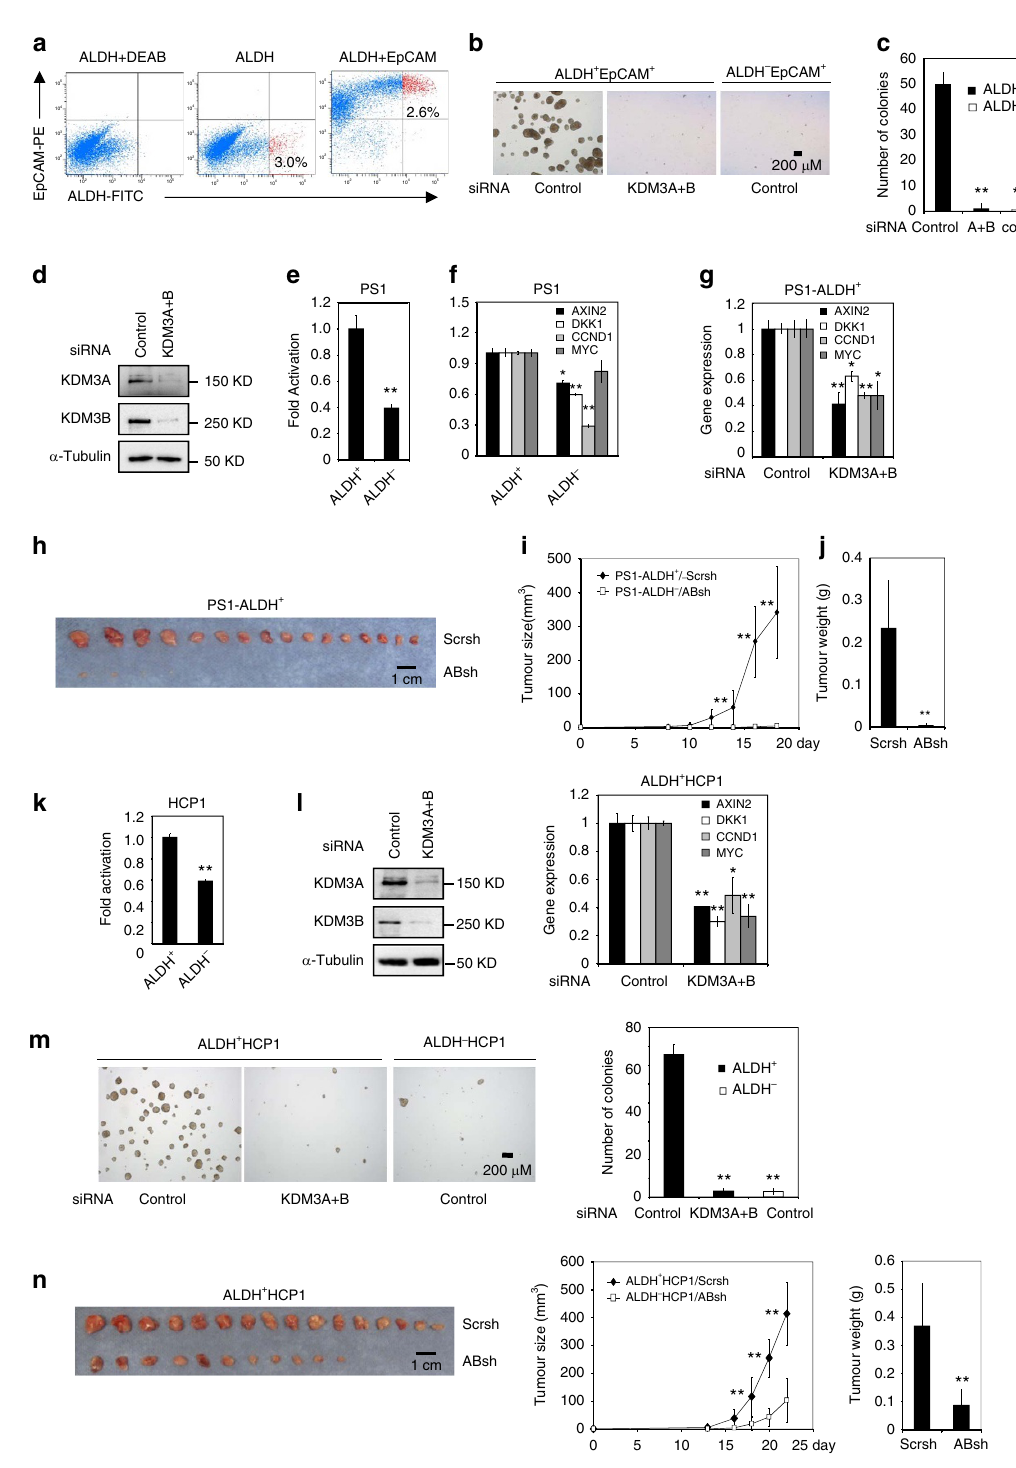
Figure 4 | KDM3A/B are required to maintain tumorigenic potentials of human colorectal CSCs. ( a ) Isolation of ALDH þ EpCAM þ cells from human CRC tissues of patient case #1 (PS1) by FACS. ( b , c ) The knockdown of KDM3A/B inhibited tumorsphere formation of ALDH þ EpCAM þ cells from PS1. ** P o 0.01, unpaired two-tailed student’s t -test ( n ¼ 3). ( d ) The knockdown of KDM3A/B by siRNA in ALDH þ EpCAM þ cells from PS1. ( e ) The Topflash activity was significantly higher in ALDH þ EpCAM þ cells than in ALDH (cid:2) EpCAM þ cells from PS1. ( f ) The expression of Wnt target genes was higher in ALDH þ EpCAM þ cells than in ALDH (cid:2) EpCAM þ . ( g ) The knockdown of KDM3A/B inhibited the expression of AXIN2, DKK1, CCND1 and MYC in ALDH þ EpCAM þ cells from PS1 ( h – j ) The knockdown of KDM3A/B significantly inhibited tumour growth of ALDH þ EpCAM þ cells in Nude mice. Tumour growth ( i ) was monitored for 3 weeks and the weight of the tumors from each group ( j ) were compared at the end of experiments. ** P o 0.01, unpaired two-tailed student’s t -test ( n ¼ 16). ( k ) The Topflash activity was significantly higher in ALDH þ HCP1 cells than in ALDH (cid:2) HCP1 cells. ( l ) The knockdown of KDM3A/B in ALDH þ HCP1 cells inhibited the expression of AXIN2 , DKK1 , CCND1 and MYC . ( m ) The knockdown of KDM3A/B inhibited tumorsphere formation of ALDH þ HCP1 in vitro . ( n ) The knockdown of KDM3A/B inhibited the tumorigenic potential of ALDH þ HCP1 cells in vivo . ** P o 0.01, unpaired 2-tailed Student’s t -test ( n ¼ 16).